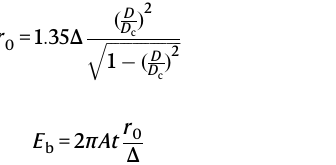
layers. b Out-of-plane component of the magnetisation m z across the skyrmion diameter in the different layers. c Simulated spin texture in a 1×2 μ m 2